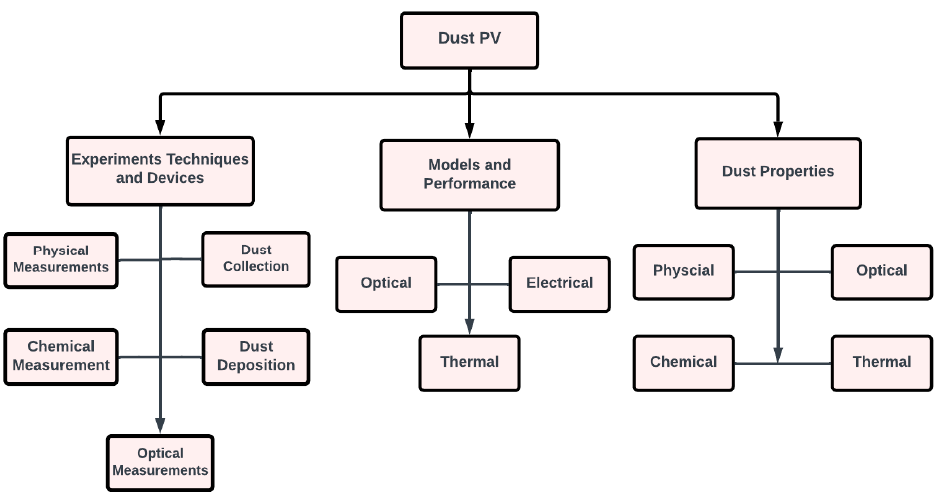
Figure 1. Illustration of the three aspects of dust’s impact on PV systems.